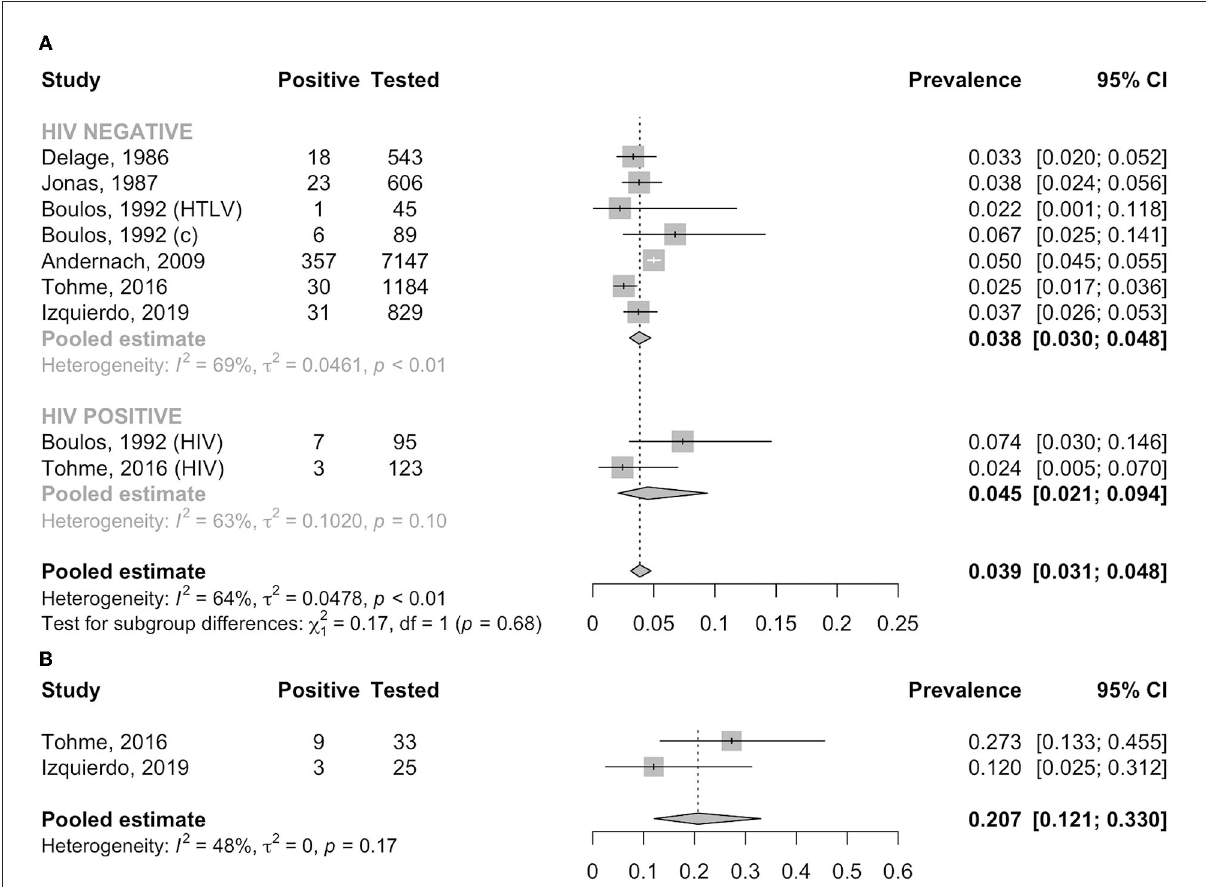
FIGURE5 (A) Prevalence of HBsAg in pregnant women by HIV status. c, control group; HIV, human immunodeficiency virus positive group; HTLV, human T-cell lymphotropic virus positive group. (B) Prevalence of high viral load ( ≥ 200,000 IU/ml) in HBsAg-positive pregnant